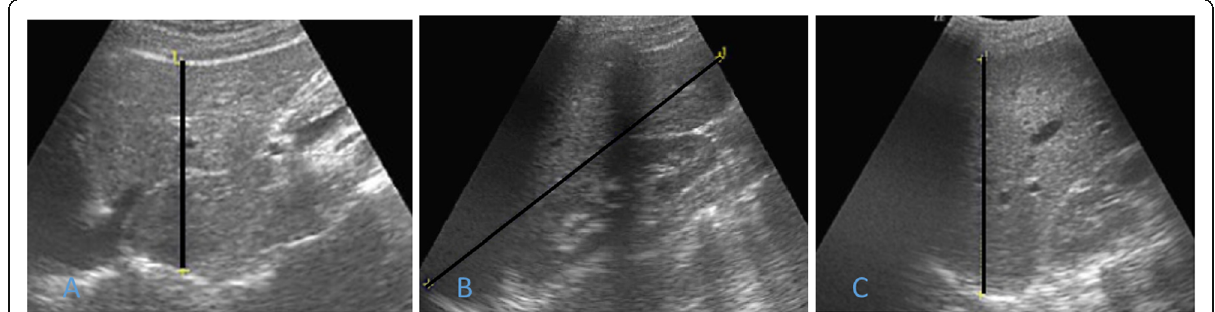
Fig. 2 The three linear measurements of liver. a The left lobe of the liver. b , c The right lobe of the liver